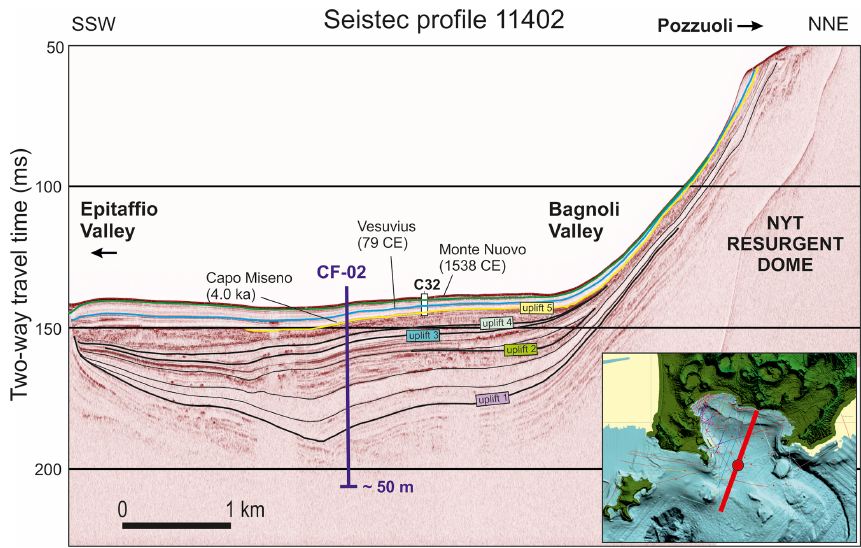
Figure 11. High-resolution single-channel seismic profile across the southern slope of the NYT resurgent dome and proposed location of drill site CF-02. Unconformities labeled as uplift 1–5 are interpreted as the result of a series of seafloor deformation phases associated with phases of the deformation of the resurgent structure. Correlation of tephra layers sampled by gravity core C32 is after Sacchi et al.